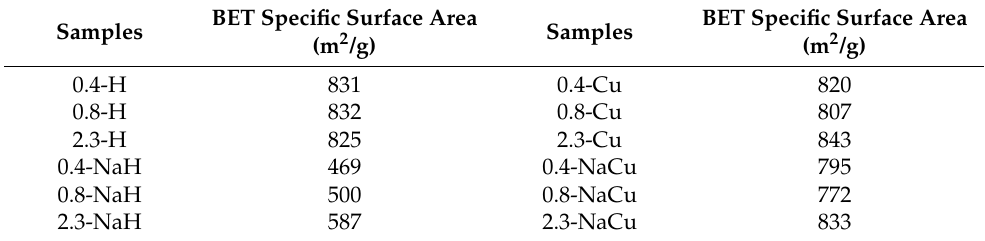
Table 1. BET Specific surface area of